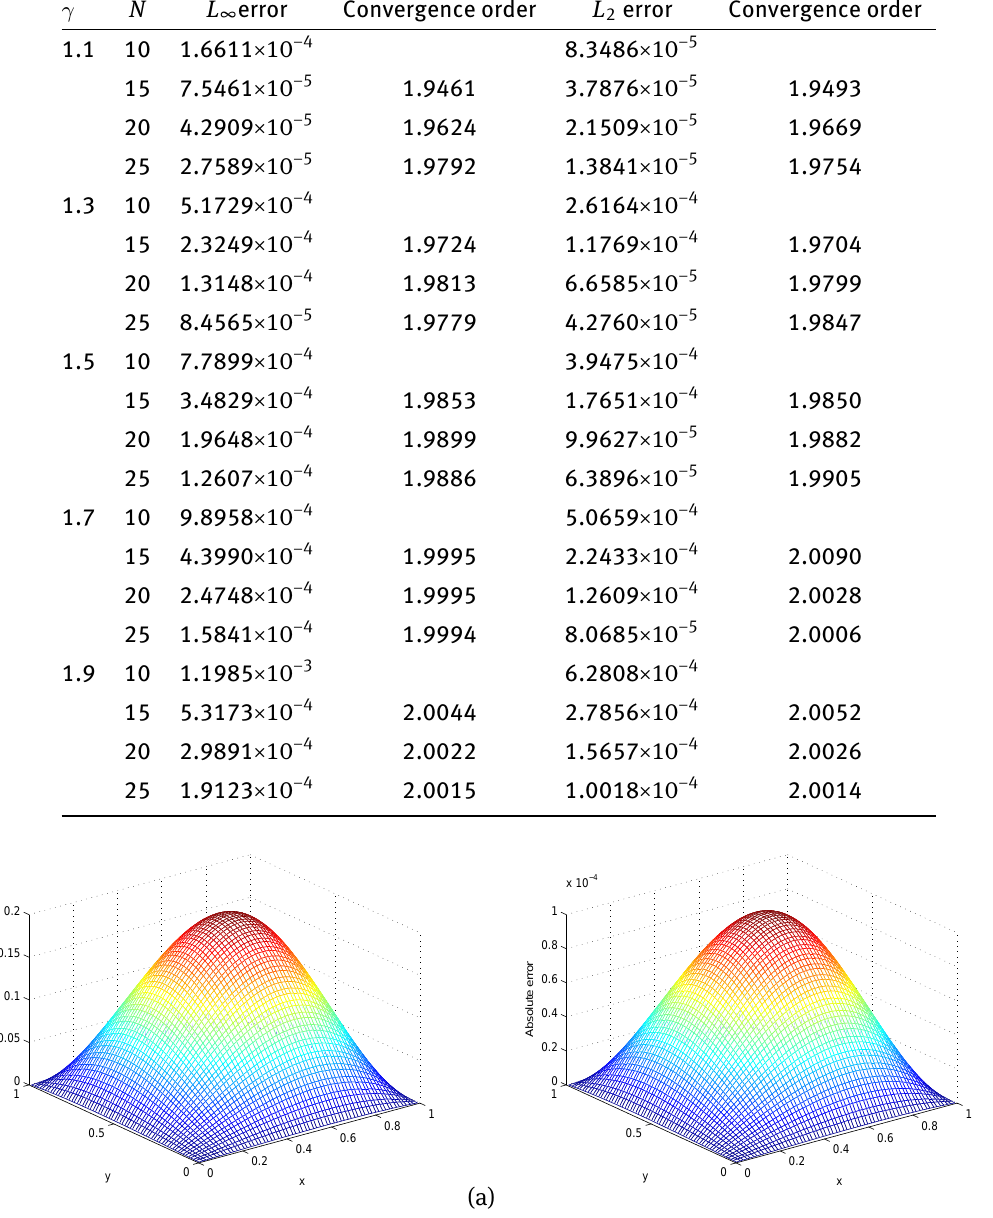
Figure 3: Numerical solution (a) and global error (b) for Example 3 with γ = 1.7 at T = 1 ( h = 1/32, τ = 1/32 ).